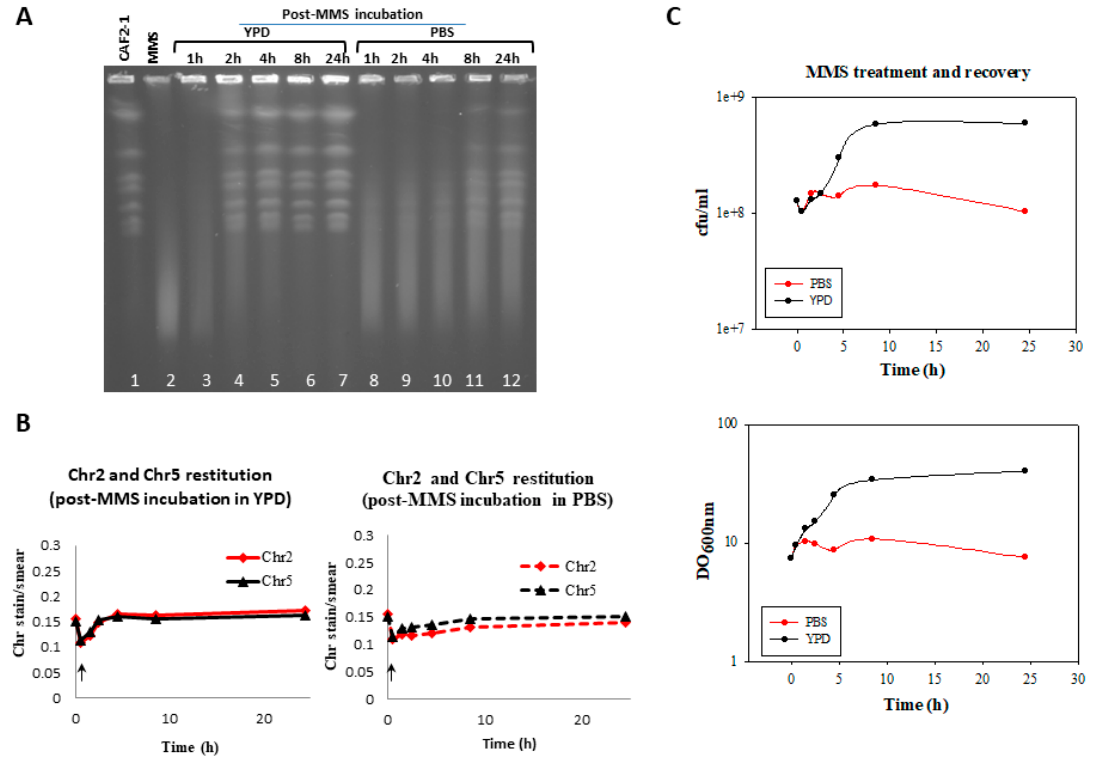
Figure 3. Induction and repair of HDBs by C. albicans cycling and resting wild type cells. C.